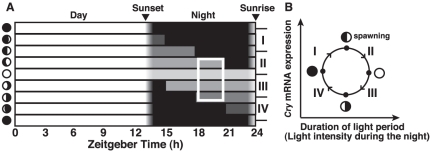
Models for photoperiodic regulation of SgCry expression by moonlight and for a lunar limit cycle.(A) Schematic of solar light phase in Okinawa, moonlight phase, and moonlight intensity during the experiments. A putative photo-repressive phase is indicated by white frame. (B) Lunar limit cycle model served by SgCry as a state-variable. SgCry mRNA level decreases from first lunar quarter to last lunar quarter when moonlight intensity is relatively high and exposed time of moonlight is relatively long (Phase II, Phase III. SgCry mRNA levels increase from last lunar quarter to first lunar quarter (Phase IV–Phase I).